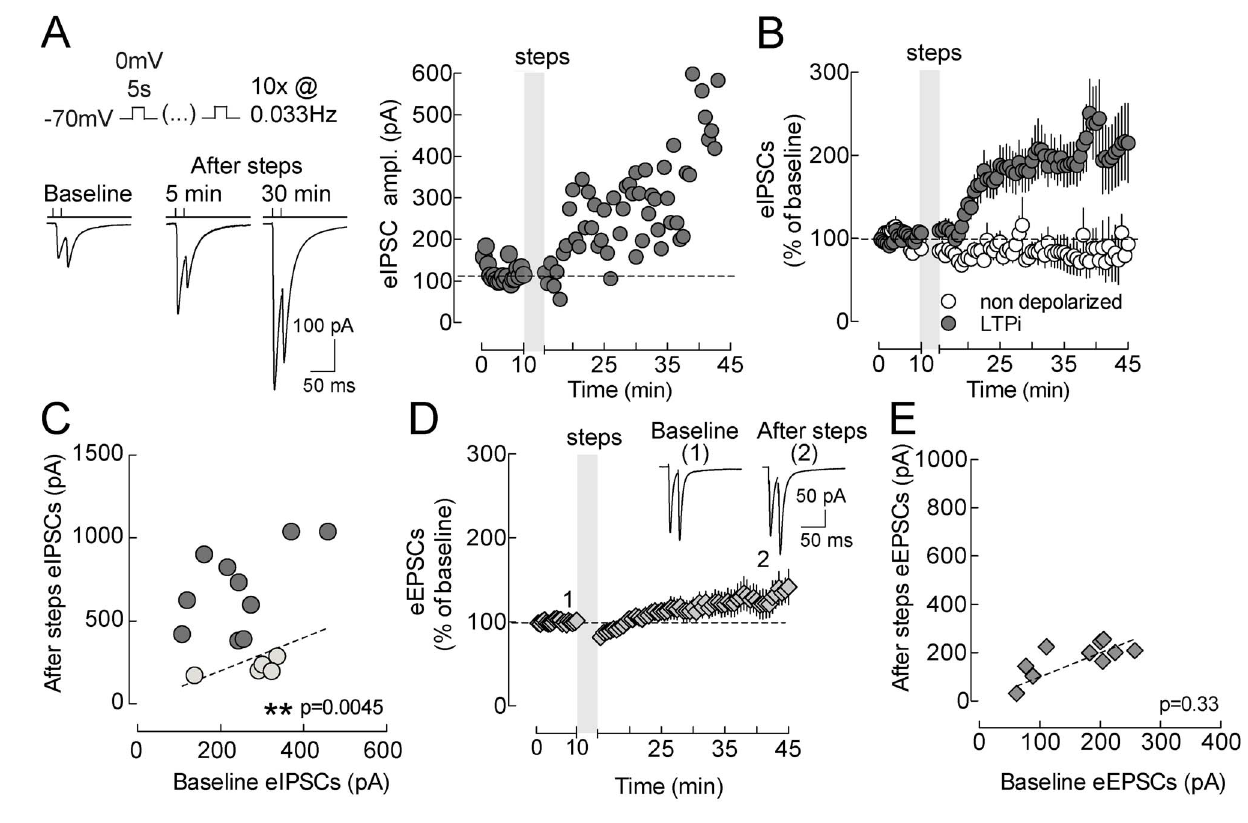
Figure 1. Postsynaptic depolarization of layer V pyramidal neurons selectively potentiates GABAergic inputs. (A, Left) Representative voltage-clamp traces of monosynaptic extracellularly evoked pairs of IPSCs evoked at 50 Hz, in the continuous presence of ionotropic AMPA/Kainate glutamate receptor antagonists (DNQX, 10 m M), before and at two time points after 10 intracellular depolarizations to 0 mV (5 s, delivered every 30 s; schematized on top). Each trace is the average of 10 sweeps. Shown are responses to paired-pulse stimulations. Postsynaptic depolarizations resulted in a strong increase of eIPSC amplitude. (A, Right) Time course of IPSCs (the first of the paired-pulse responses, averaged in 30 s bins) of the cell of (A), displaying a clear LTPi. The shaded area refers to postsynaptic depolarizing steps. (B) Average time course of relative IPSC changes in cells subject to somatic depolarization (solid circles) and nondepolarized cells (open circles). The shaded area refers to postsynaptic depolarizing steps. (C) Plot of individual eIPSC amplitudes before ( x -axes) versus 20 min after postsynaptic depolarization (steps) ( y -axes). The majority of layer 5 pyramidal neurons expressed a long-term change in eIPSC amplitude, which we designated as LTPi (grey circles). A small percentage of the cells do not express LTPi (open circles). Dotted line indicates unitary values (no change). Grey symbols and white symbols refer to pyramidal neurons that did and did not express LTPi, respectively. (D) Average time course evoked glutamatergic EPSCs, isolated pharmacologically in the continuous presence of gabazine. The same depolarizing steps did not cause any significant change in EPSC amplitudes. Inset shows representative EPSC traces taken immediately before and 30 min after induction of LTPi. (D). (E) eEPSC amplitudes after postsynaptic depolarizations plotted as a function of their baseline values. Dotted line indicates unitary values (no change). Numbers (1 and 2) refer to times of trace